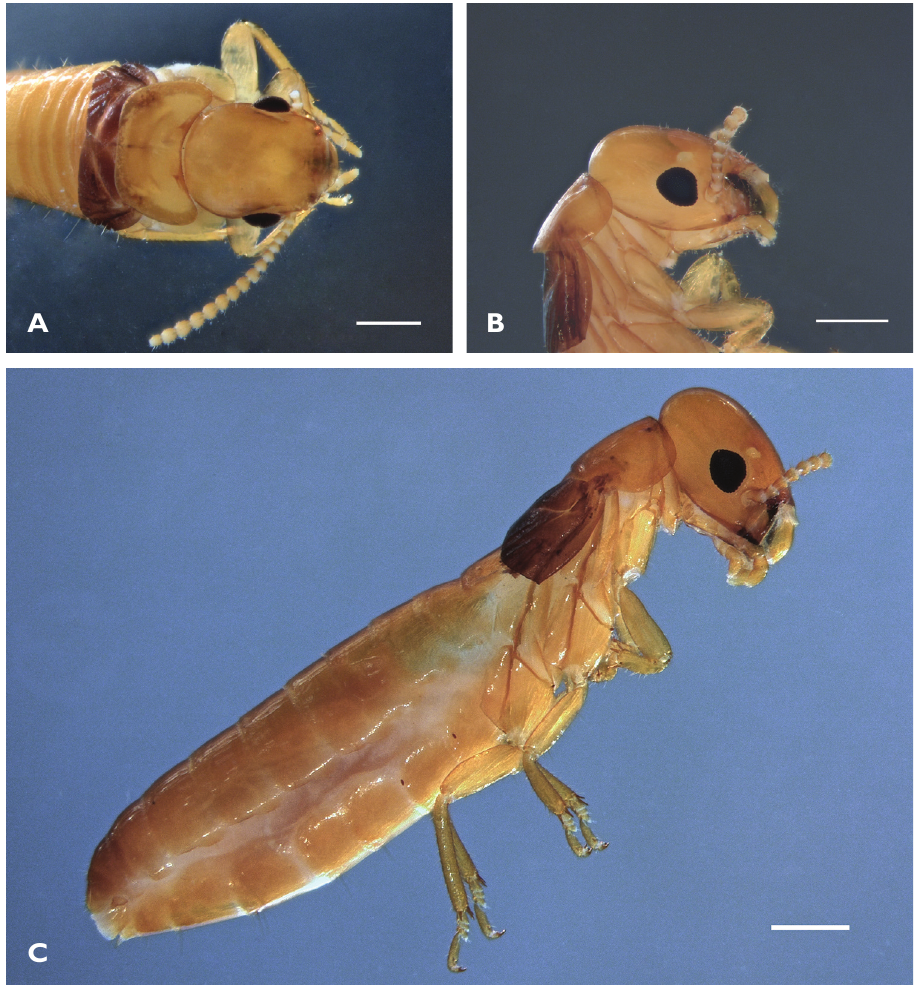
Figure 2. Proneotermes macondianus sp. n. imago: A Head in dorsal B lateral, and C whole body in lateral. Scale bars: 0.5